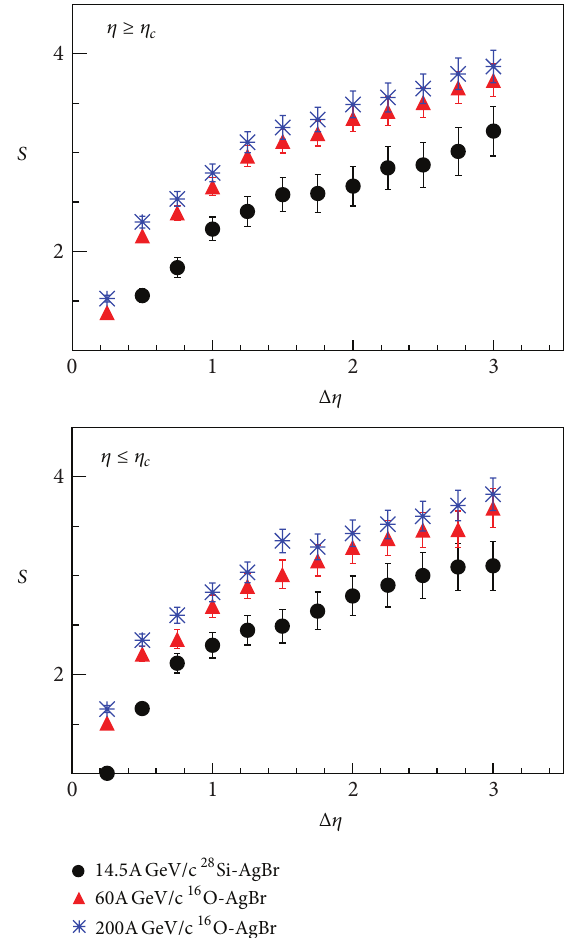
Figure 4: The same plots as in Figure 3 but for the IEH